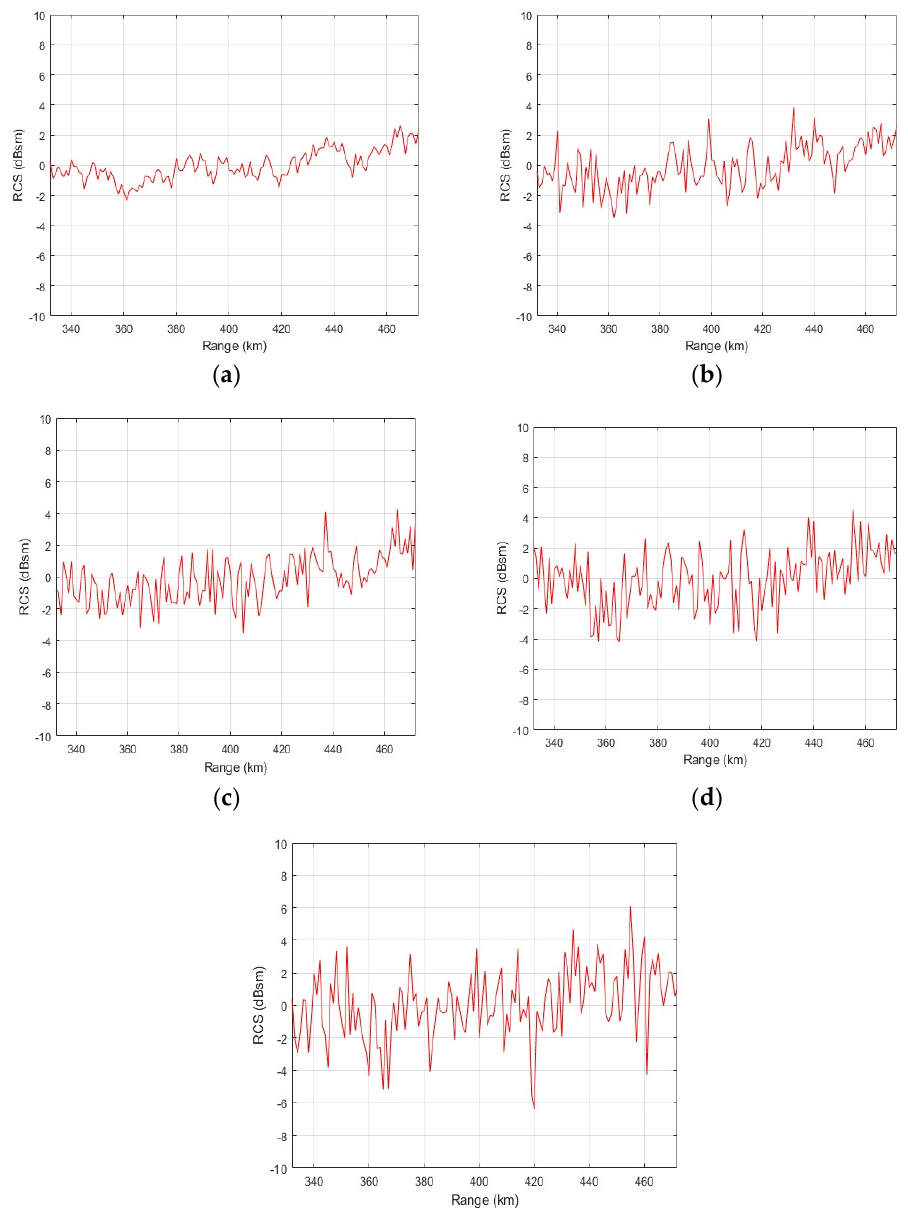
Figure 6. The dynamic RCS graphs according to the standard deviation of Gaussian noise added in class 1 dataset: ( a ) standard deviation of 0.5; ( b ) standard deviation of 0.9; ( c ) standard deviation of 1.2; ( d ) standard deviation of 1.5; ( e ) standard deviation of 1.8.